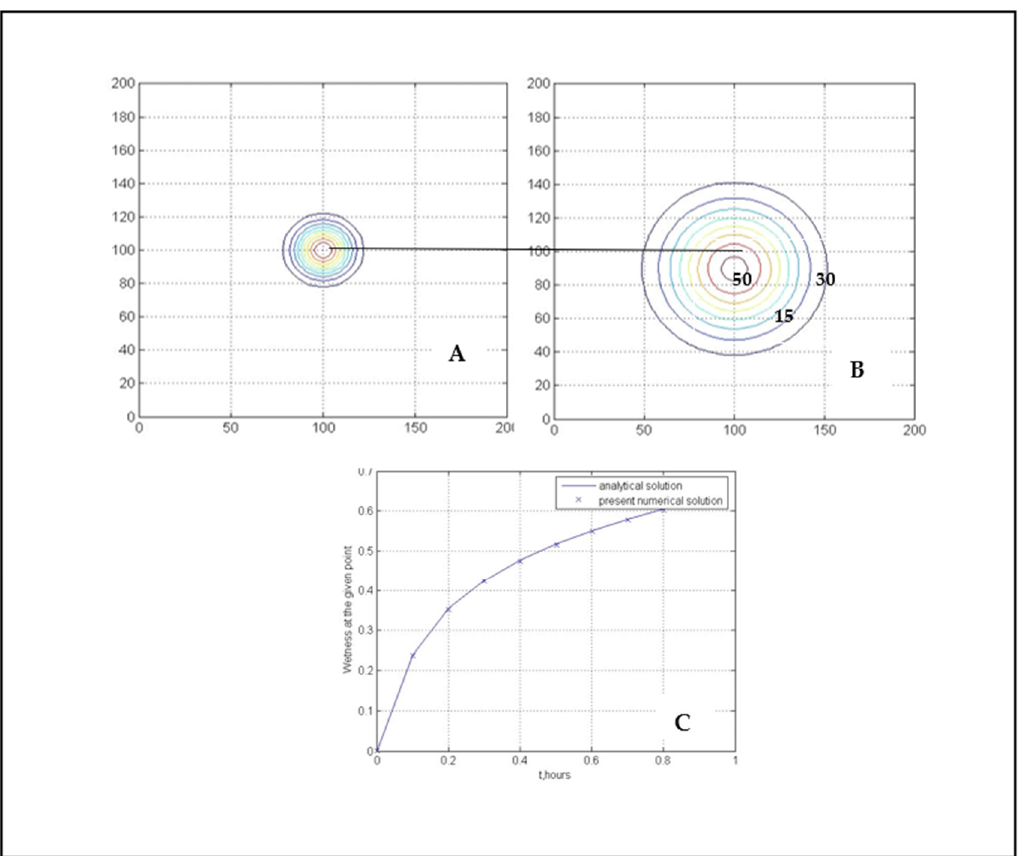
Figure 2. ( A ) Distribution of soil water content after 36 min of infiltration. Applying 1800 cm 3 (0.6 × 3000 cm 3 ). Numerical values of θ are shown in ( B ). ( B ) displays water content after fifteen redistribution minutes (0.25 h). The solid horizontal line connects ( A , B ) to emphasize the 10 cm downward movement of the center of mass. ( C ) compares changes in the analytical and numerical solution of ( Q − Q r ) wetness taken at different time steps at a single point located about 25 cm from ( Q s − Q r ) the center of mass.